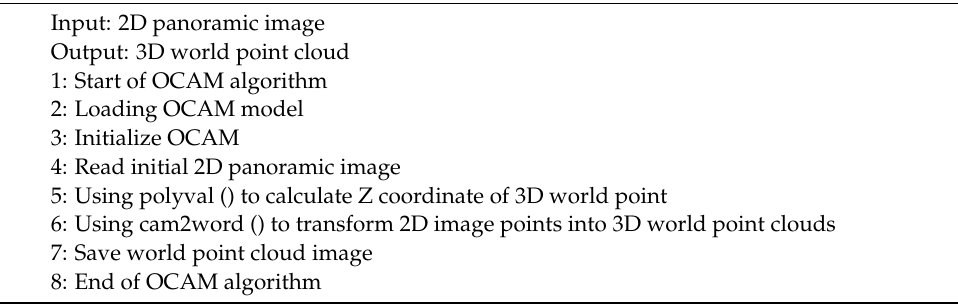
Algorithm 2 Transform 2D panoramic image to 3D world point cloud.